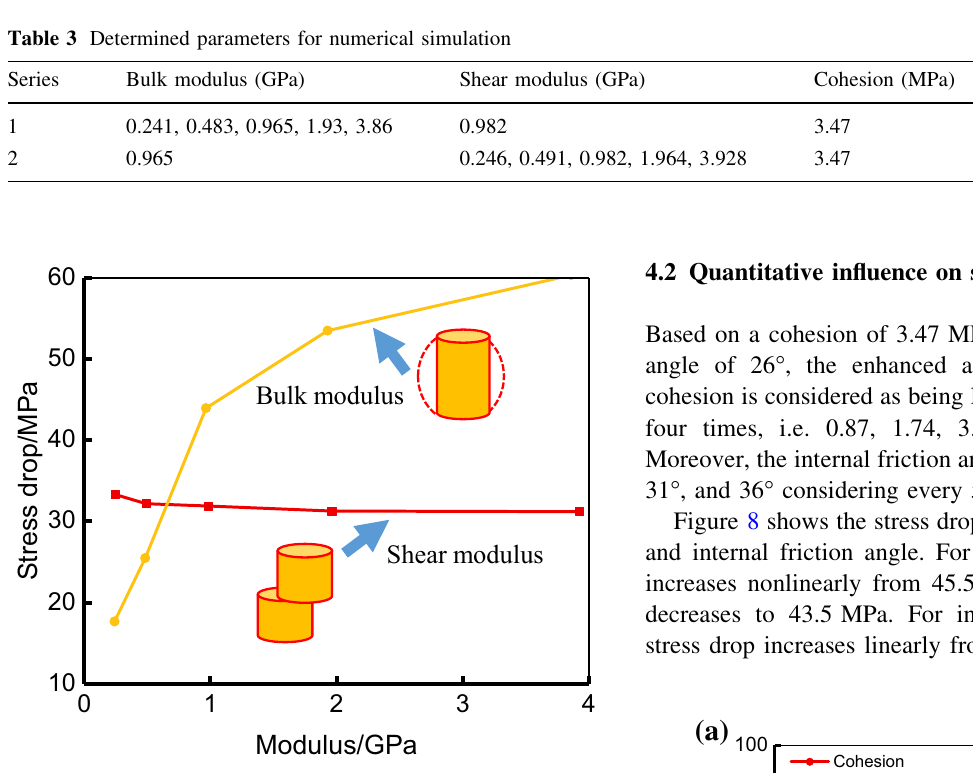
Fig. 6 Stress drop with bulk and shear moduli